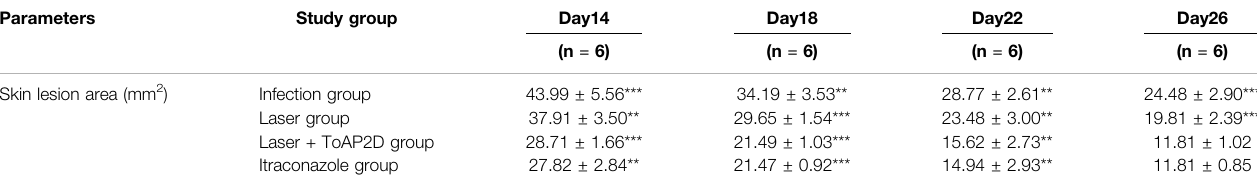
TABLE 4 | The mice foot skin lesion area analysis.